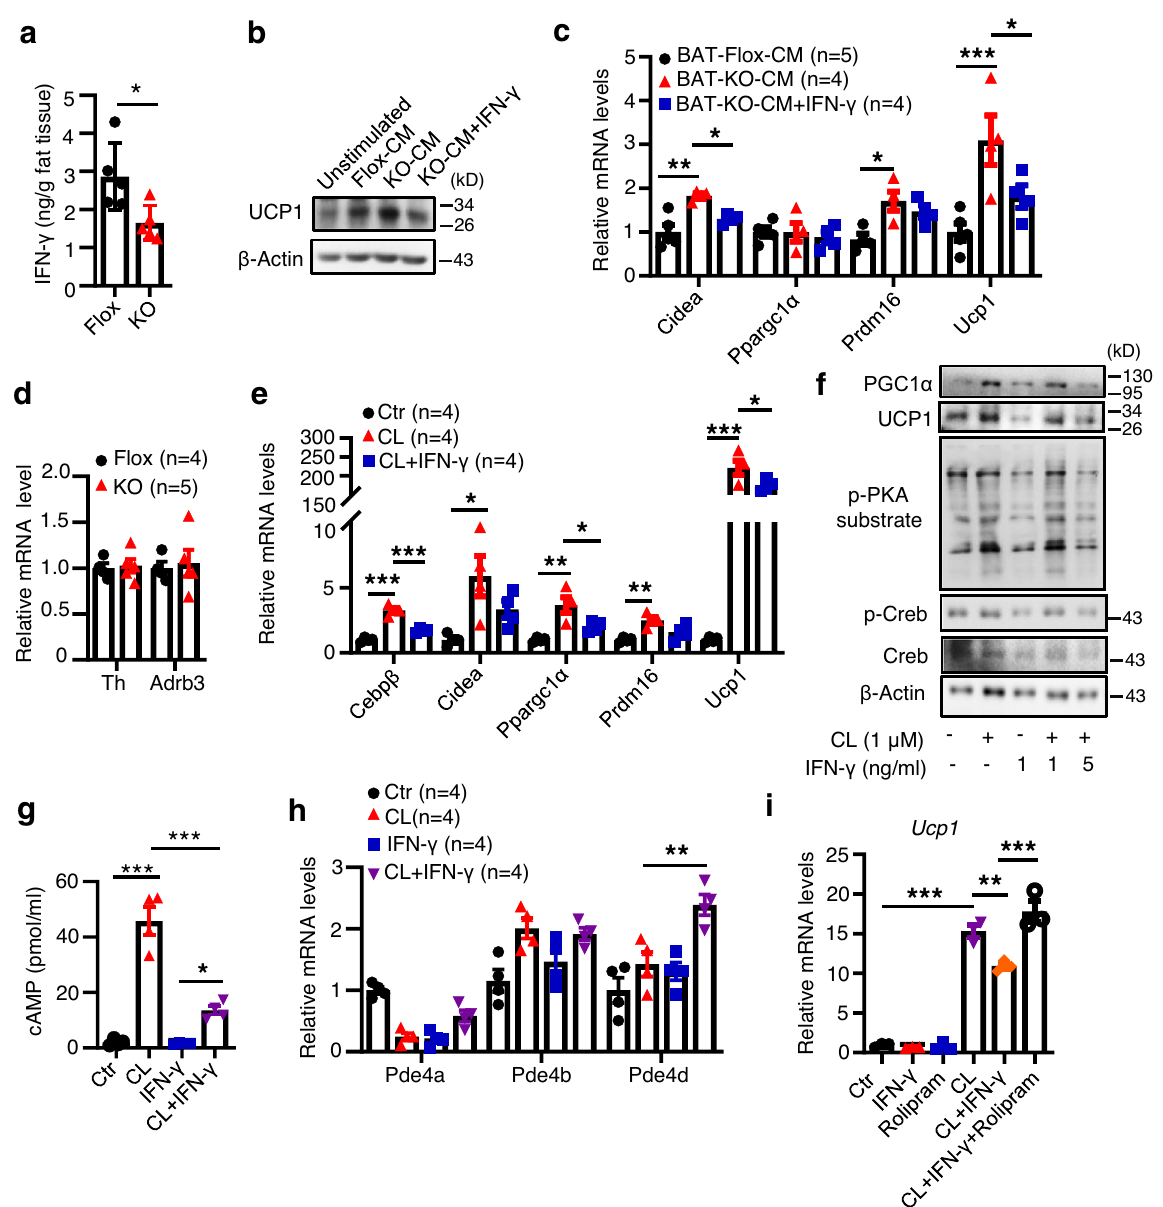
Fig. 6 IFN- γ inhibits thermogenic gene expression in brown adipocytes. a BAT explant cultures from DsbA-L CD4-KO mice and control littermates fed an HFD for 5 weeks were stimulated with a submaximal dose of PMA/ionomycin for 24 h. IFN- γ secreted into the medium was collected and quanti fi ed by ELISA. ( n = 5/group). b , c Differentiated primary brown adipocytes were left untreated or treated with conditioned medium (CM) of BAT collected in a in the presence or absence of IFN- γ for 24 h. UCP1 expression and thermogenesis markers were tested by western blot ( b ) and qPCR analyses ( c ), respectively. ( n = 4 – 5/group). d The mRNA levels of TH and β 3AR ( Adrb3 ) in the BAT of DsbA-L CD4-KO mice ( n = 5) and control littermates ( n = 4) fed an HFD for 5 weeks. e Differentiated primary brown adipocytes were treated with CL316,243 (1 μ M) in the presence or absence of IFN- γ (5 ng/ml) for 24 h. The mRNA levels of thermogenic markers were determined by qPCR analyses. ( n = 4/group). f Differentiated primary brown adipocytes were treated with CL316,243 (1 μ M) in the presence or absence of IFN- γ (1 or 5 ng/ml) for 24 h. The phosphorylation and protein level of CREB, phosphorylation of PKA substrates, and protein levels of PGC1 α , and UCP1 were analyzed by western blot. g cAMP levels accumulated in differentiated BFC adipocytes that were untreated or treated with CL316,243 (1 μ M) in the presence or absence of IFN- γ (5 ng/ml) for 24 h. ( n = 4/group). h mRNA levels of PDE4 family members in differentiated BFC adipocytes treated as in g . ( n = 4/group). i Differentiated BFC adipocytes were left untreated or pre-treated with rolipram (1 μ M) for 30 min, followed by stimulated with CL316,243 (1 μ M) in the presence or absence of recombinant IFN- γ protein (5 ng/ml) for 24 h. Ucp1 mRNA level was determined by qPCR analyses. ( n = 3/group). Data shown are representative of three independent experiments. All data are presented as mean ± SEM. Statistical values p < 0.05 (*), p < 0.01 (**), p < 0.001 (***) are determined by two-tailed unpaired Student ’ s t -test ( a , d ) or ANOVA adjusted for multiple comparisons ( c , e , g – i ). Source data are provided as a Source Data